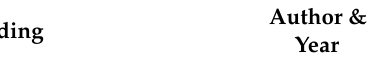
Table 1. Summary of studies evaluating ER stress responses in selected pathogenic coronaviruses which display more similarities to